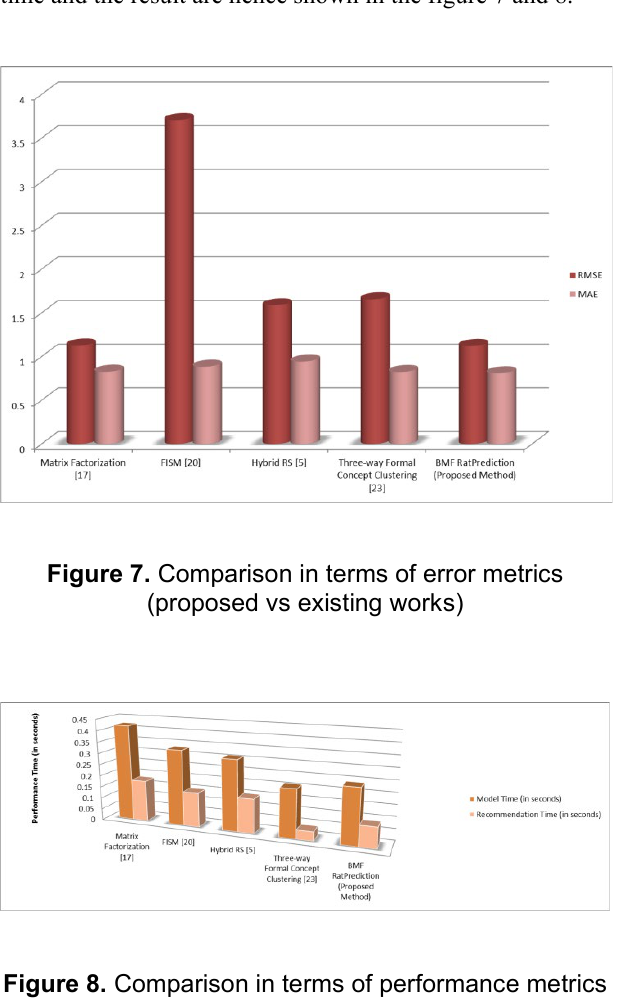
Figure 8. Comparison in terms of performance metrics (proposed vs existing works)